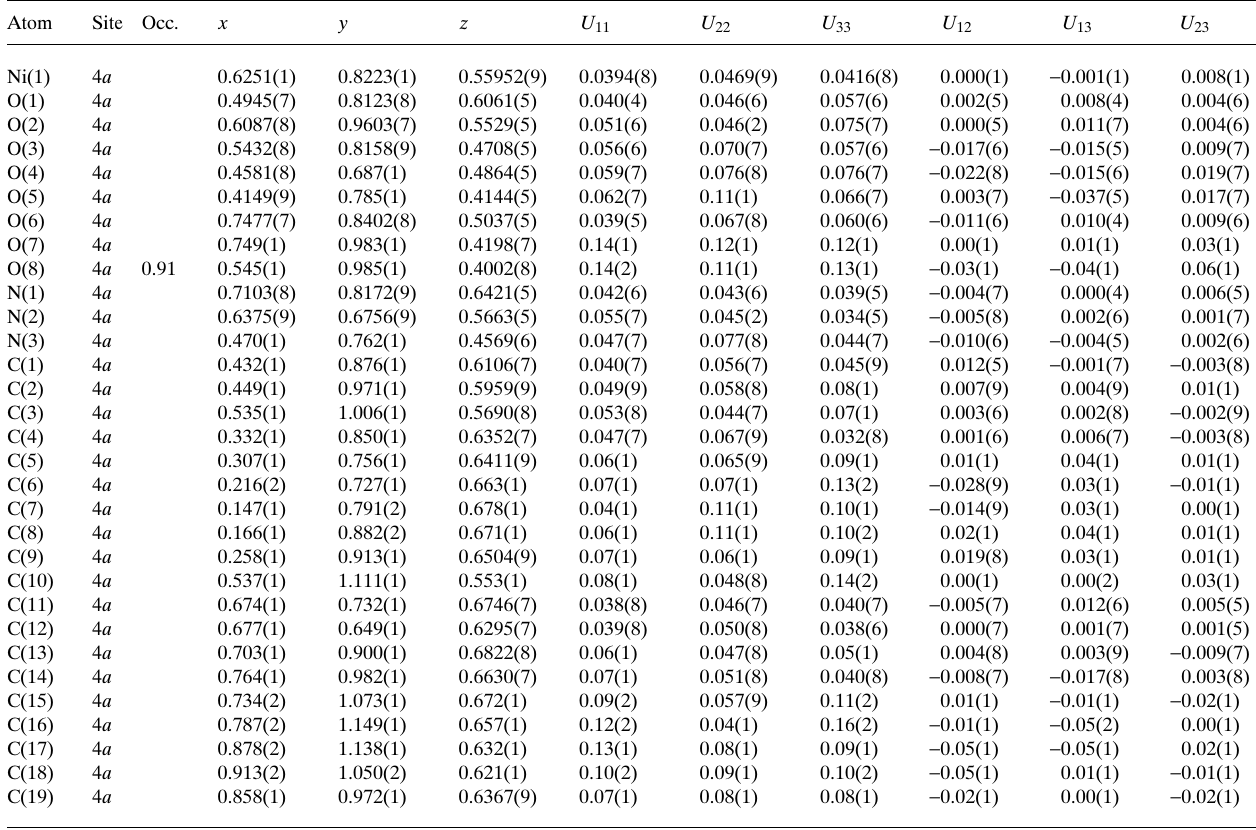
Table 3. Atomic coordinates and displacement parameters (in Å 2 ) .